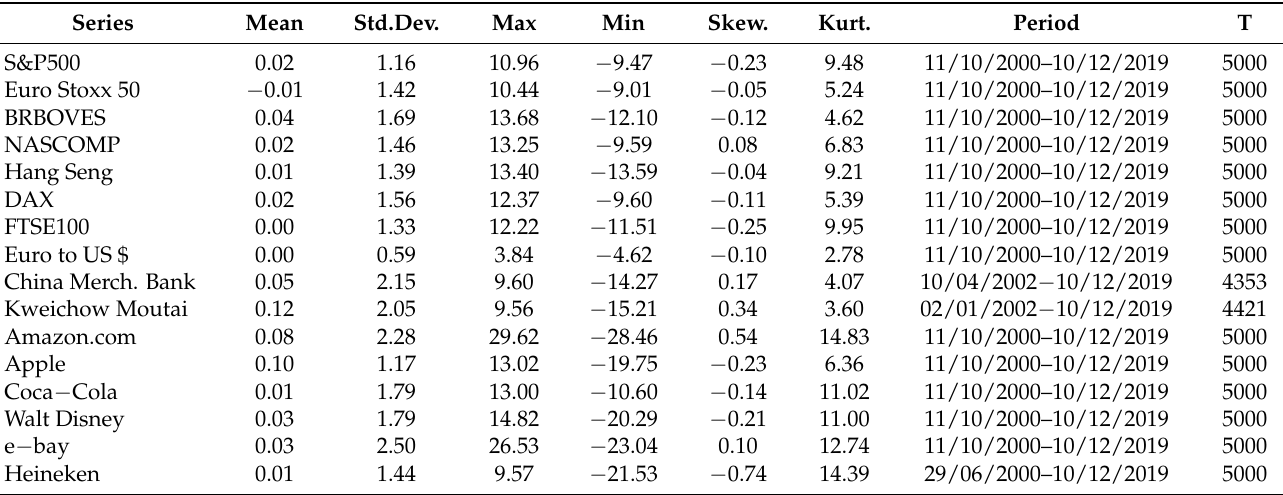
Table 1. Descriptive Statistics for Daily Log-Returns.